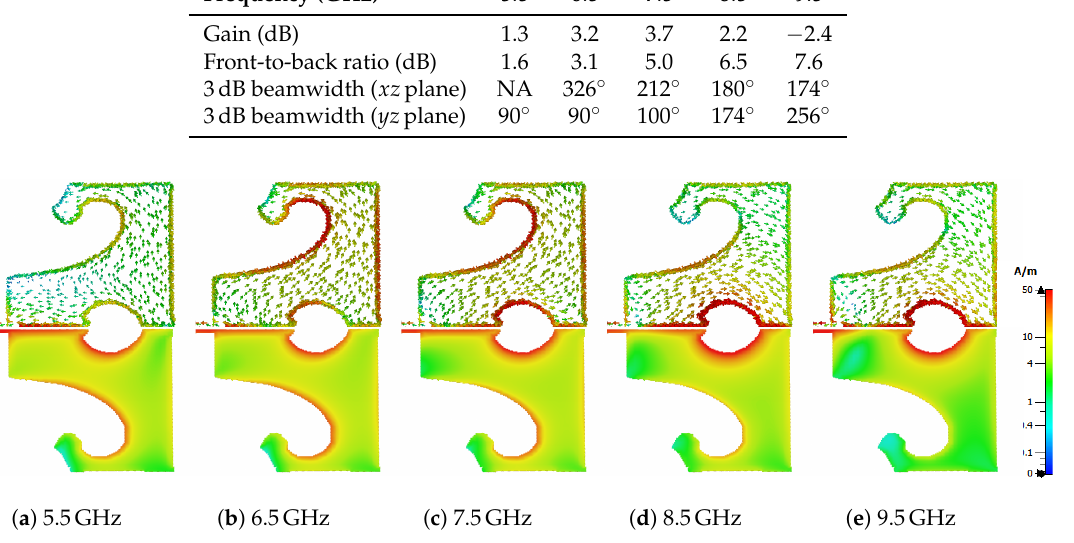
Figure 15. Surface current distribution on Antenna